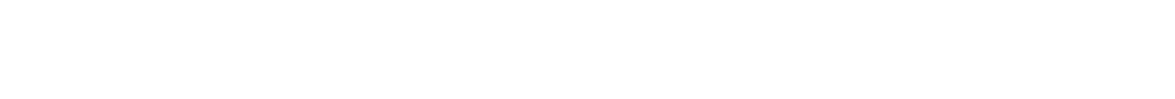
FIGURE 3 | Position of all subjects ’ mean fl exion axis (MFA) intersection points in the lateral plane and medial plane. Red points represent the average center, and thehorizontaland vertical linesrepresentthestandarddeviationoftheaxis intheanterior – posteriordirectionand thedistal – proximaldirection. (A) Inthemedial view,the origin point is the medial trochlear center. (B) In the lateral view, the origin point is the lateral trochlear center.